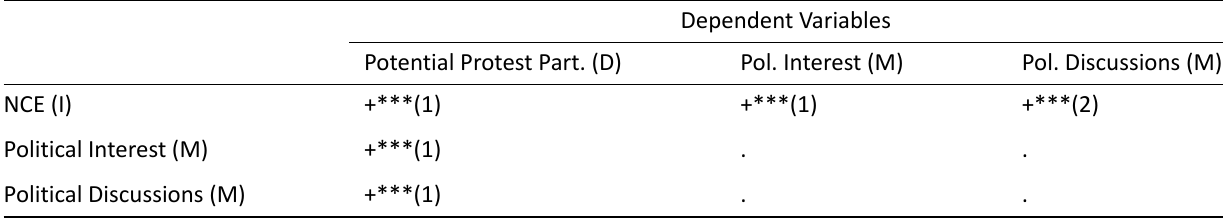
Table 1. Bivariate correlations between the dependent variable, independent variable and mediators. Dependent Variables Potential Protest Part.